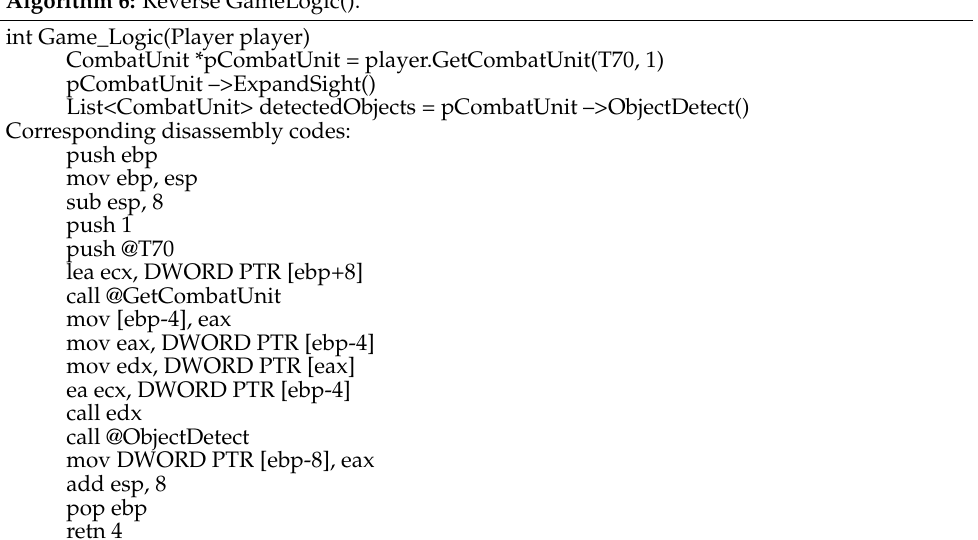
Algorithm 6: Reverse